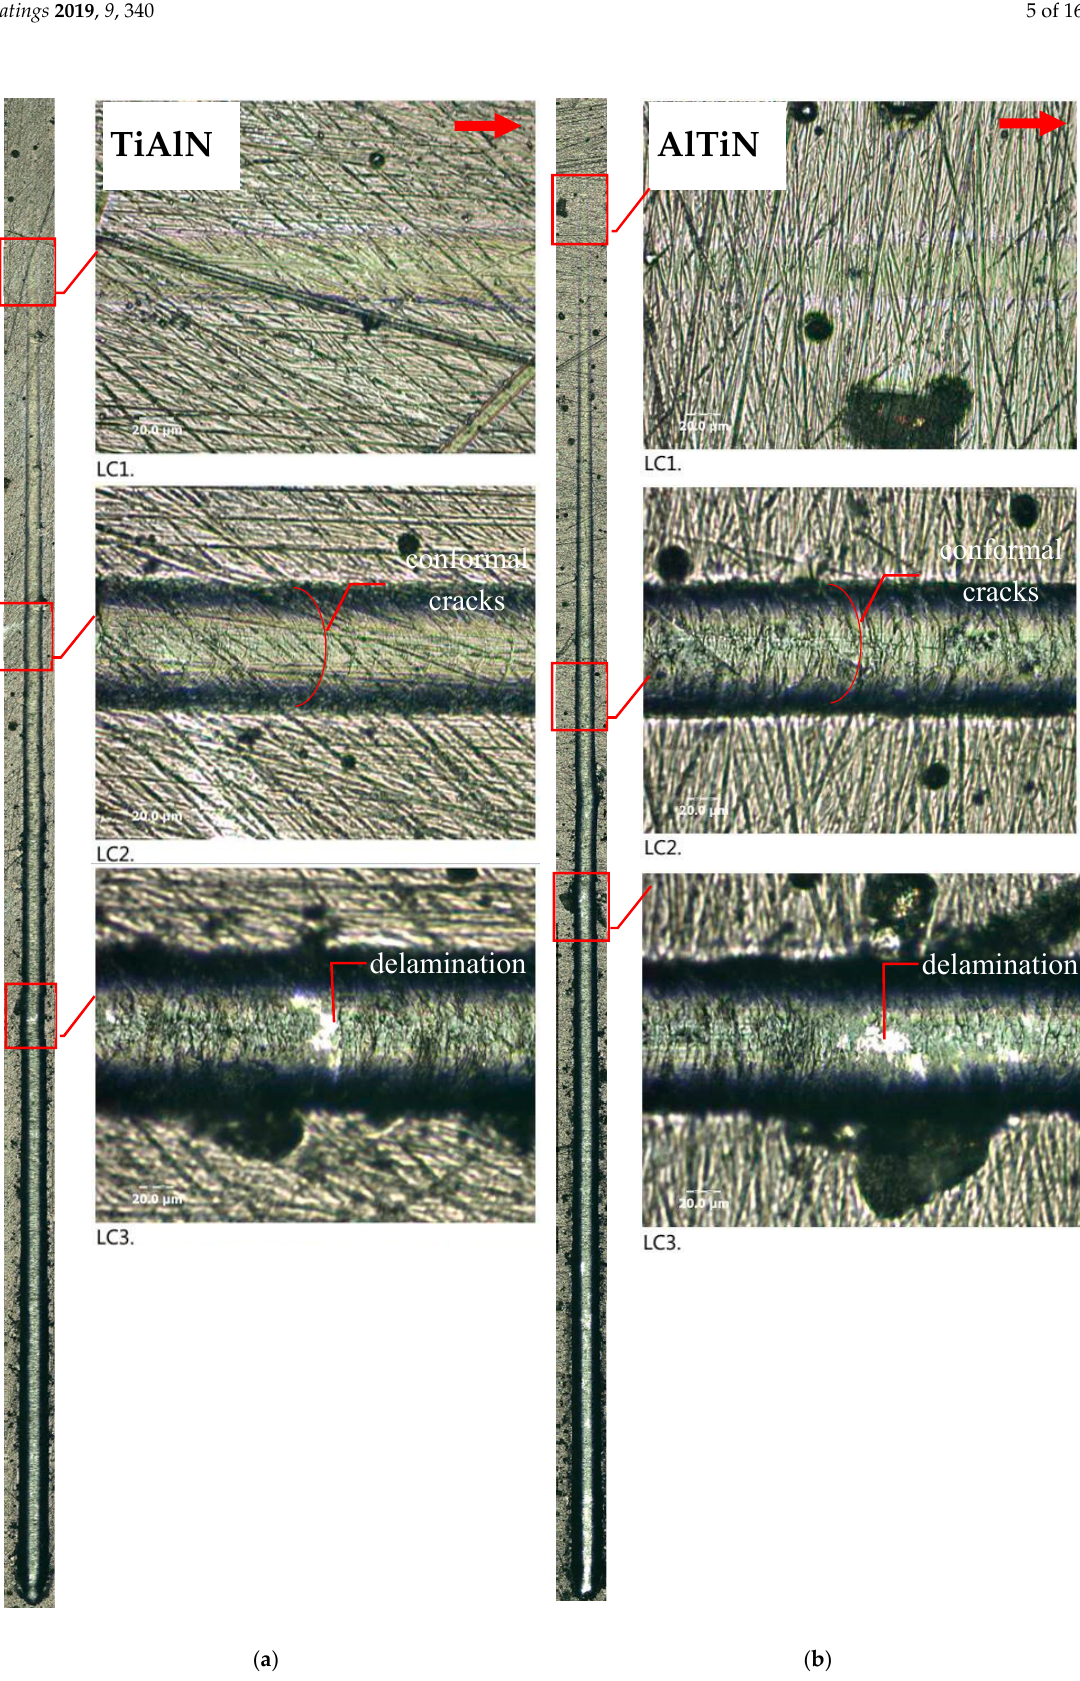
Figure 3. Scratch traces: ( a ) TiAlN; ( b ) AlTiN and enlarged characteristic areas of Lc1, Lc2 and Lc3. (total scratch trace 3 mm), scratch direction marked by an